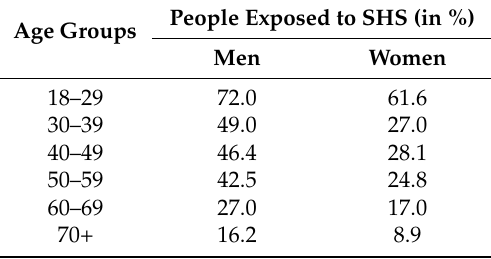
Table 2. Exposure to SHS in Germany, stratified by sex and age groups, 2009 1